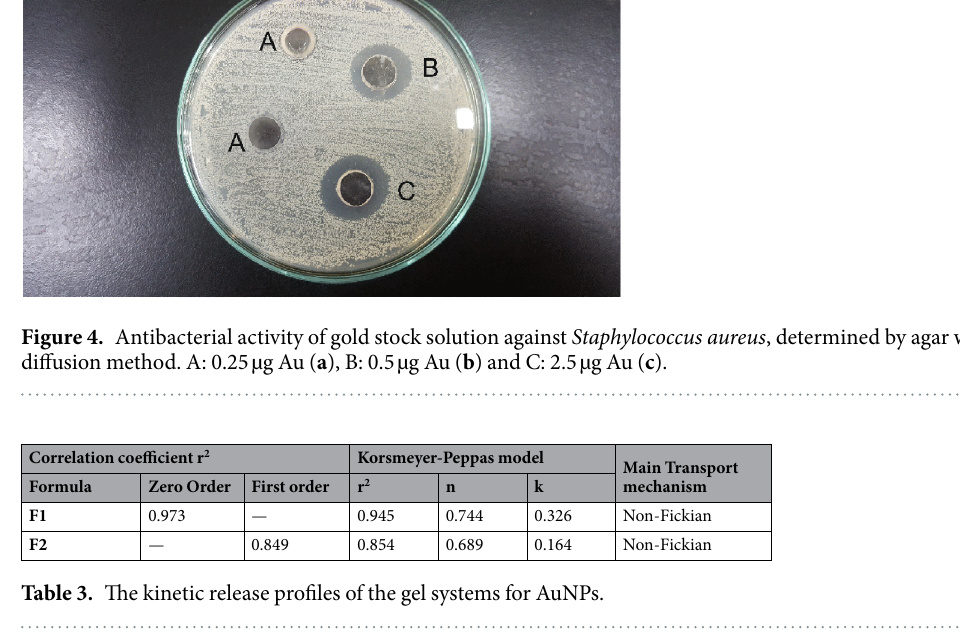
Three different concentrations of AuNPs stock solutions were investigated; 0.25, 0.5 and 2.5 µ g (Fig. 4). The lowest concentration of AuNPs (0.25 µ g) did not show any